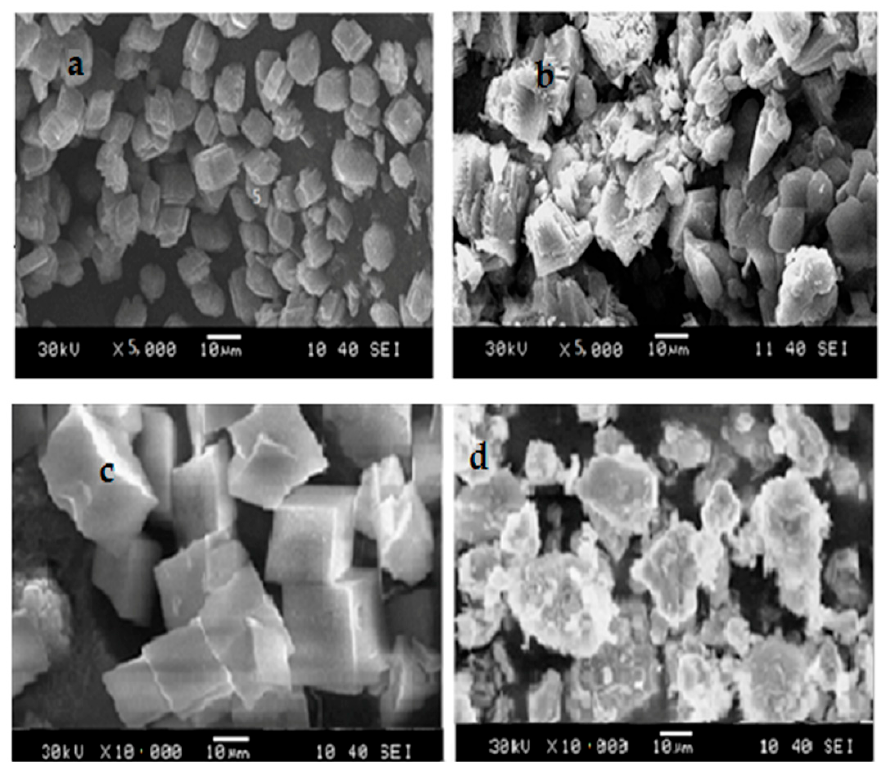
Figure 12. FT-IR spectra of the calcium carbonate crystals formed in the blank ( a ) and in 10 mg·L − 1 CA-co-GLC ( b ).